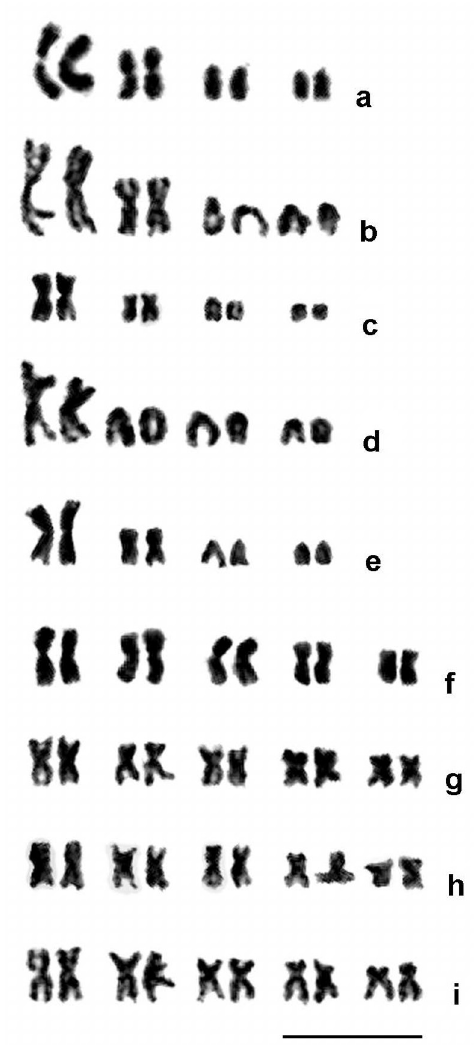
Figure 2. Diploid mitotic karyograms of nine Aphelinus species. a A. atriplicis b A. certus c A. hordei d A. kurdjumovi e A. varipes f A. coreae g A. glycinis h A. rhamni , i A. daucicola . Species in the A. varipes complex have 2n = 8 versus 2n = 10 in the A. mali and A. daucicola complexes. Scale bar: 10